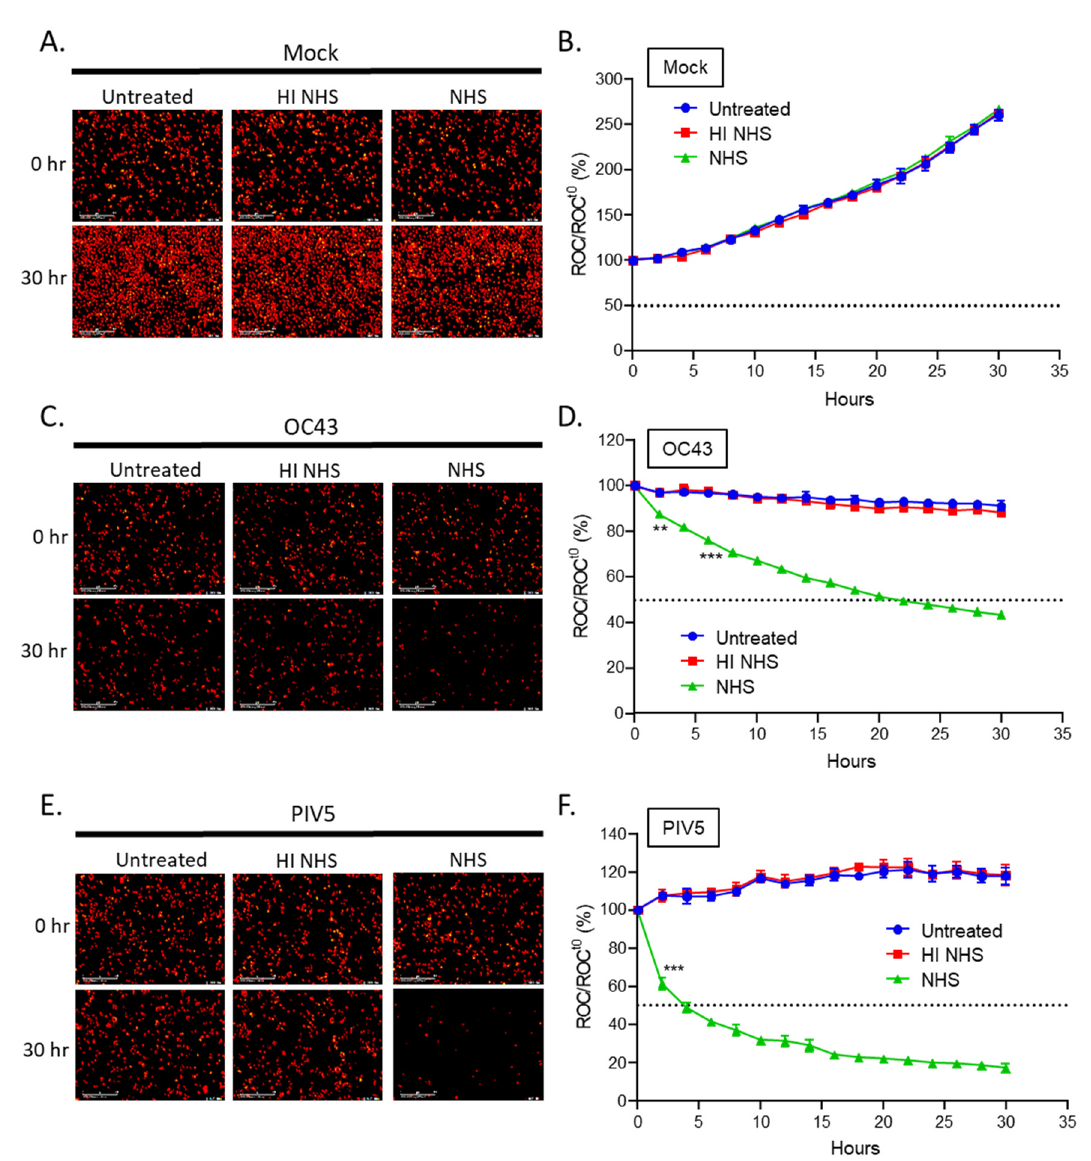
Figure 2. NHS lyses OC43 infected lung cells at a slower rate than PIV5 infected cells using real-time cell viability assays. Human lung H1299-NLR cells expressing nuclear red fluorescent protein were uninfected (mock) ( A , B ), or infected with OC43 ( C , D ) at an MOI of 5 TCID 50 units per cell, or PIV5 ( E , F ) at an MOI of 5 PFU/cell. Cells were left untreated or were treated with 10% HI NHS or 10% NHS. Bright field phase and red fluorescent images were recorded by real-time imaging using the IncuCyte instrument at intervals of every 2 h over a 30 h. Representative pictures at 0 and 30 h are shown in ( A , C , E ). Red object count (ROC) per well was calculated and normalized to the value at time zero (ROC t0 ) when treatments were added and expressed as percent of time zero ( B , D , F ). Values in all panels are the mean of three replicates and error bars representing standard deviation, with ** indicating p -value of <0.01 and *** indicating p -value of <0.001 comparing NHS treated versus HI NHS treated infected samples. Mock denotes uninfected control samples.